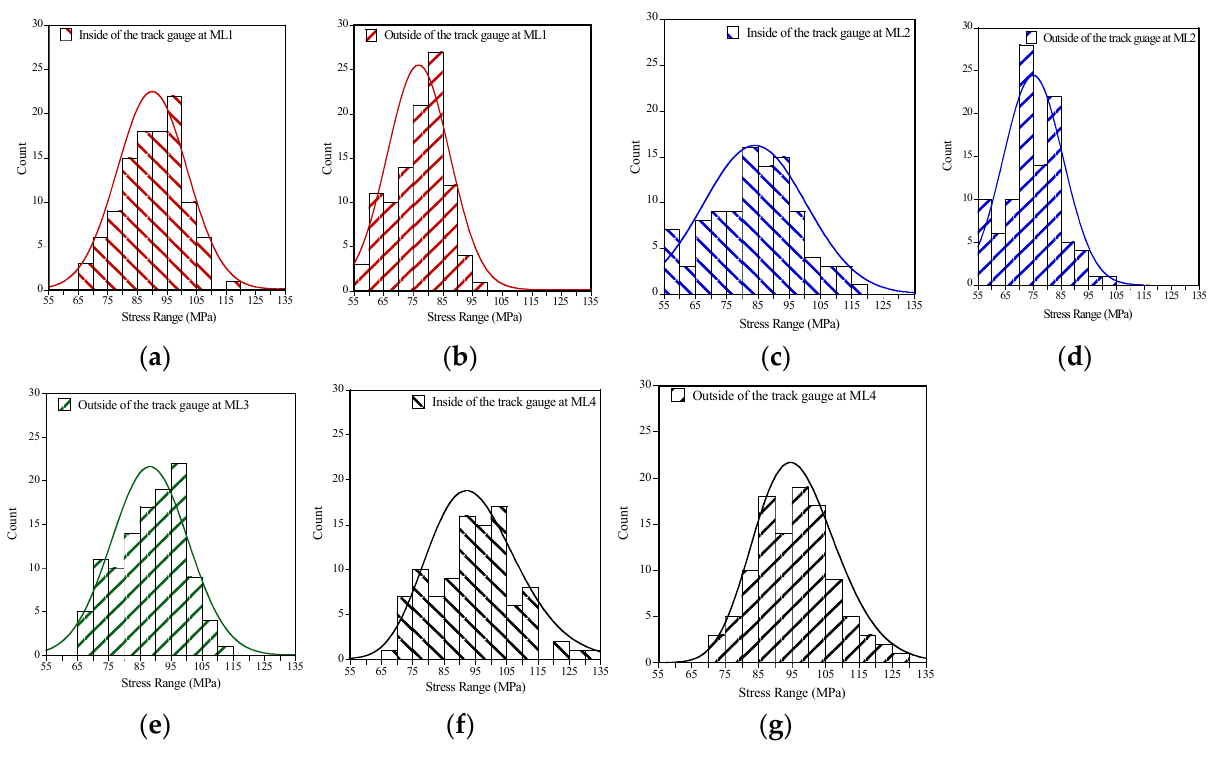
Figure 5. The histograms and PDF plots of the principal stress ranges at the four MLs: ( a ) the inside track gauge at ML1; ( b ) the outside track gauge at ML1; ( c ) the inside track gauge at ML2; ( d ) the outside track gauge at ML2; ( e ) the outside track gauge at ML3; ( g ) the inside track gauge at ML4; ( f ) the outside track gauge at ML4. Table 2. The statistical parameters of the principal stress ranges at the four MLs.